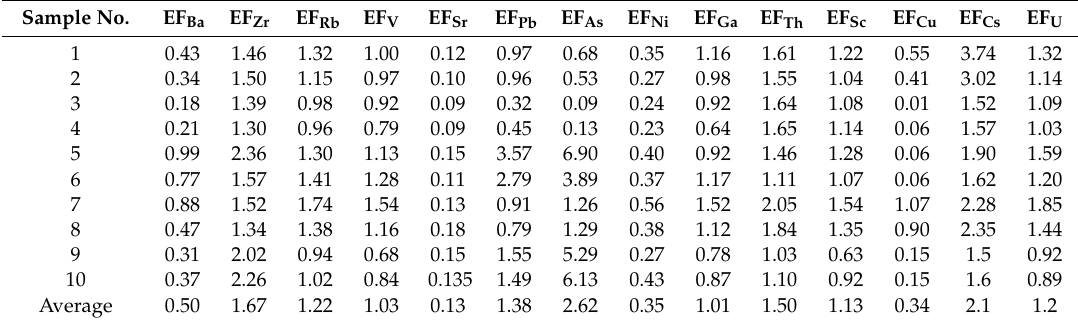
Table 5. Enrichment factors (EFs) for the selected trace elements of black shale samples from the Semanggol Formation.